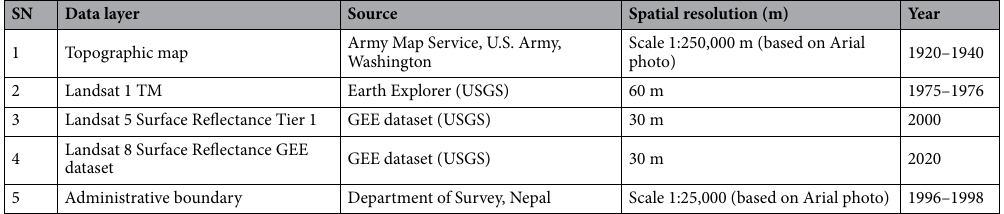
Table 6. Sources of data used in this study.